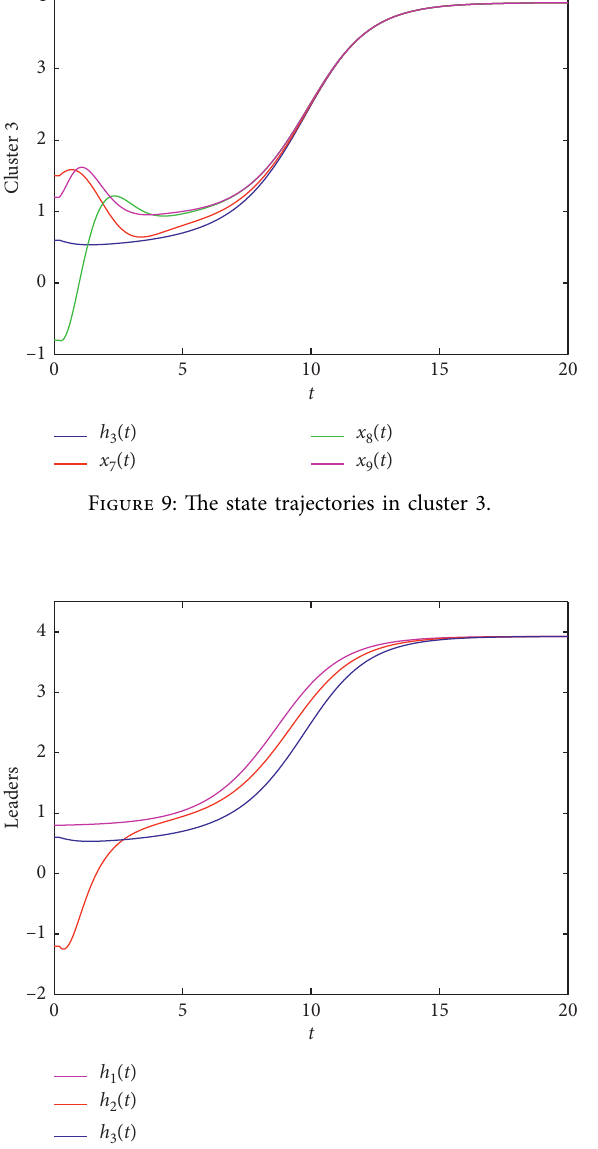
Figure 10: The state trajectories of leaders.